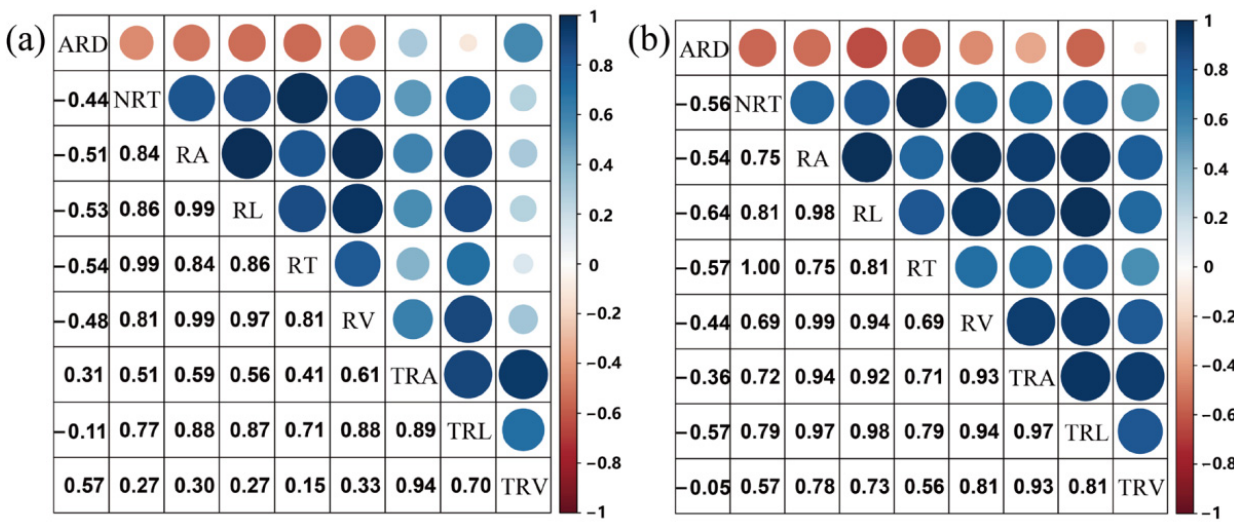
Figure 3. Correlation analysis of the nine RSA traits in 388 wheat accessions under OPC ( a ) and IPC ( b ). Intensities of the blue and red colours indicate the degree of positive and negative correlations, respectively. Circle size indicates low to high significance.